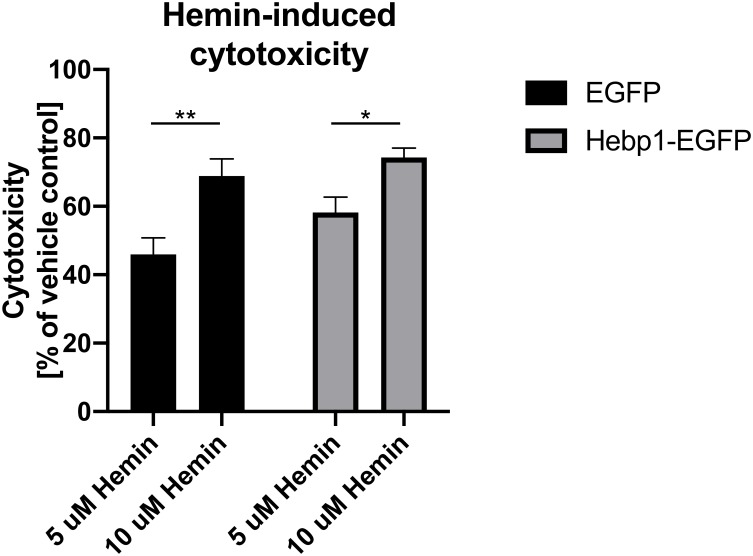
Cytotoxicity is influenced by hemin concentrations rather than cellular levels of Hebp1.Hippocampal neurons (DIV1) were infected with lentiviruses expressing either EGFP alone or Hebp1-EGFP. Seven days after transduction, the neurons were treated with 5 or 10 µM of hemin or vehicle only. Cell toxicity was assessed 24 hr after the treatment using the RealTime-Glo assay (Promega). The results shown were obtained from six independent experiments. Error bars in graphs represent mean ± SEM. Statistical significance in the datasets was assessed by two-way ANOVA followed with Bonferroni corrections for individual pairs of samples: *p<0.05 and **p<0.005.